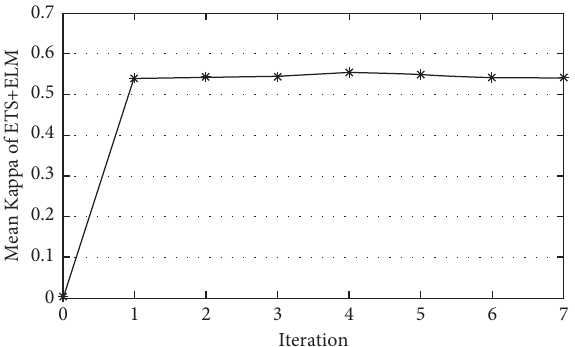
Figure 4: Iteration vs. mean Kappa value of ETS +ELM for BCI competition 2008 IIa (the Kappa value is the mean of nine subjects).